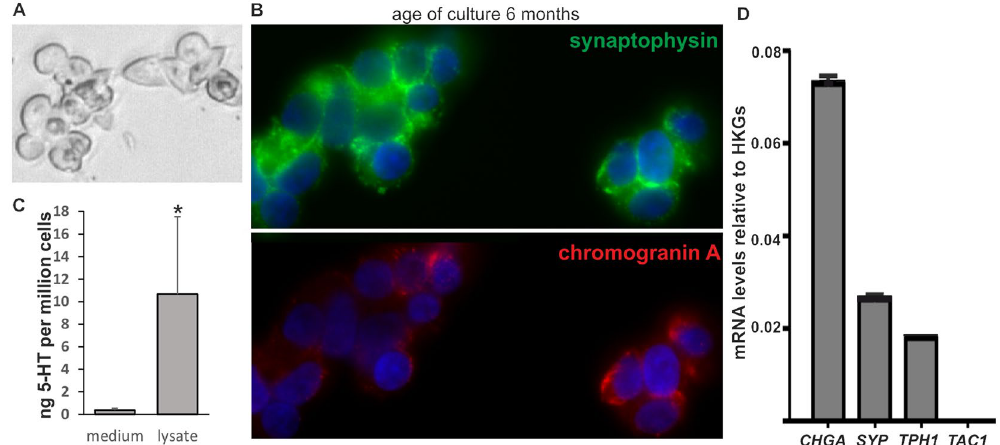
Figure 1. Expression of neuroendocrine markers in P-STS cells. ( A ) Light microscopy picture of P-STS cells adhering to the culture dish, ( B ) Immunofluorescence staining with anti-CgA (Cy3-labeled secondary antibody) and anti-synaptophysin (Alexa 488-labeled secondary antibody) after 6 months of continuous cultivation, ( C ) 5-HT in the supernatant after 1 h of incubation of adherent P-STS cells (continuously cultivated for 10 months) in serum-free medium containing 5% BSA at room temperature and in the cell lysate as determined by ELISA. * p < 0.05 as calculated by the unpaired two-tailed Student’s t -test assuming equal variances. ( D ) Expression of neuroendocrine marker genes in P-STS cells assessed by real-time PCR analysis. Real-time PCR analysis was performed using the Δ Ct method for relative quantification. Expression mRNA levels of the target gene were normalized to the average of the HKGs. Shown are genes encoding neuroendocrine markers such as CHGA (encoding chromogranin A), SYP (encoding synaptophysin), TPH1 (encoding tryptophan hydroxylase 1), and TAC1 (encoding the tachykinin peptide hormone family, substance P and neurokinin A, as well as the related peptides). Results are shown as mean values in one experiment ± SD and are representative of two independent